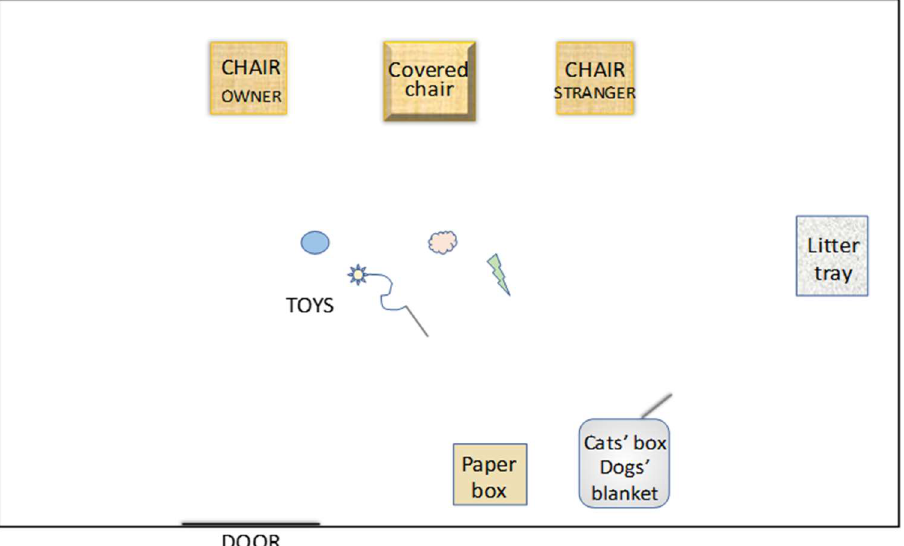
Figure 1. Illustration of the lab environment in the habituation test.